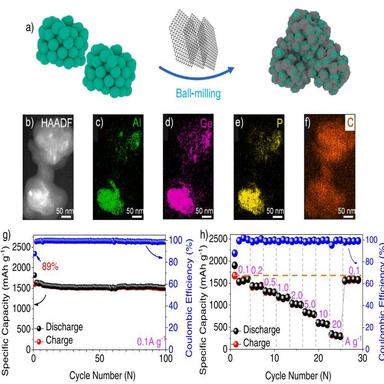
(a) Schematic of synthesis and (b)–(f) elemental mapping images of AlGeP/C composite. (g) Cycling stability and (h) and rate performance of AlGeP/C electrode.